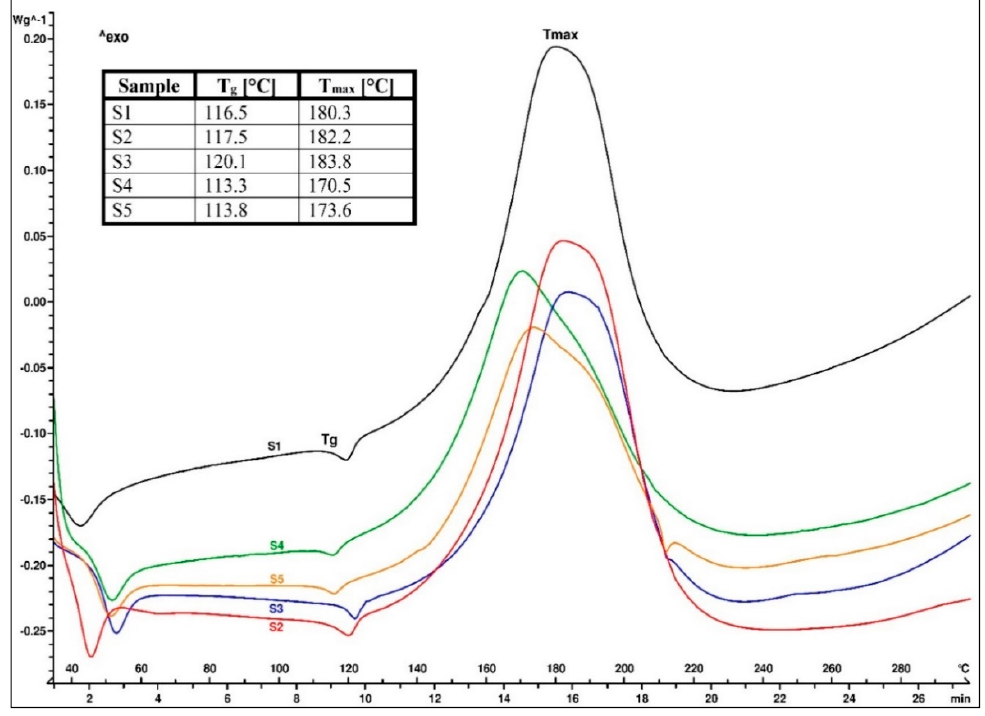
Di ff erential scanning calorimetry (DSC) thermogram of epoxy molding compound Figure 3. Differential scanning calorimetry (DSC) thermogram of epoxy molding compound (EMC) (EMC) granulates.